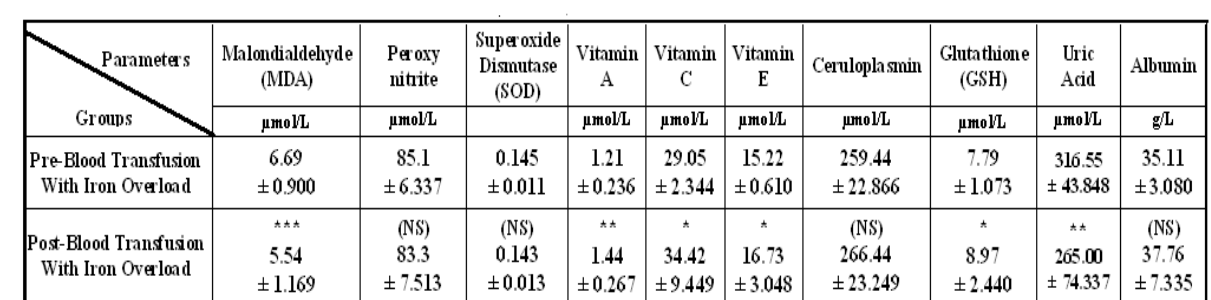
Table 2: Effects of blood transfusion in thalassemic patients, with iron overload, on lipid peroxidation and antioxidant status.